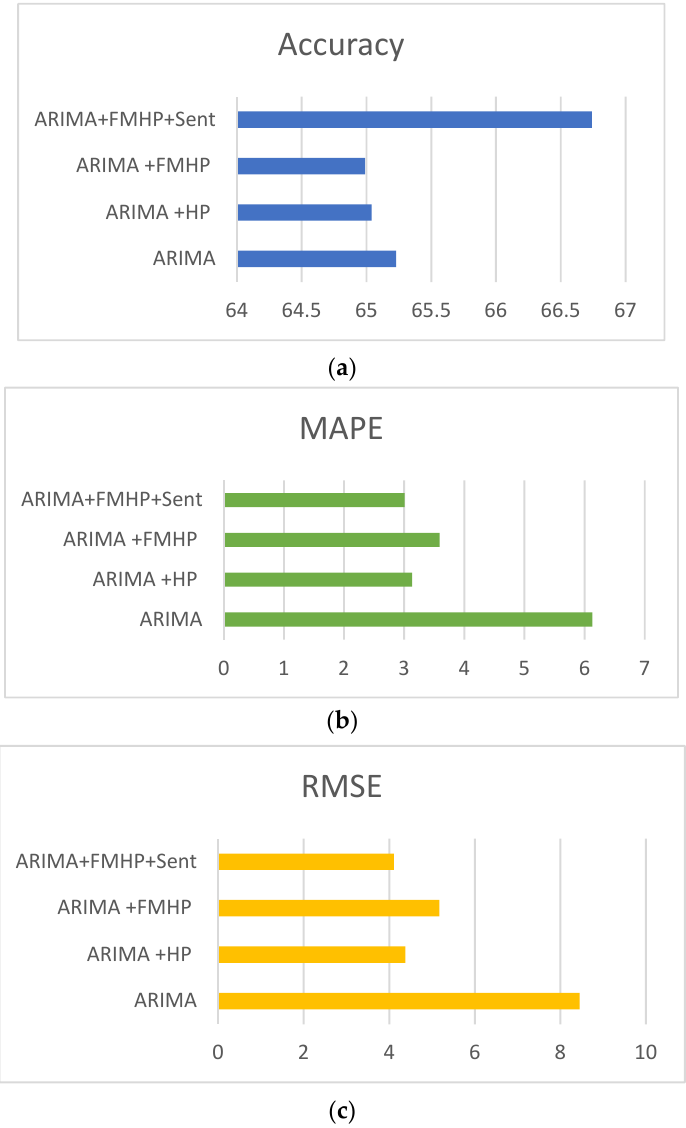
Figure 8. Performance of ARIMA in predicting the closing price of AAPL ( a ) prediction accuracy, ( b ) MAPE, and ( c ) RMSE.